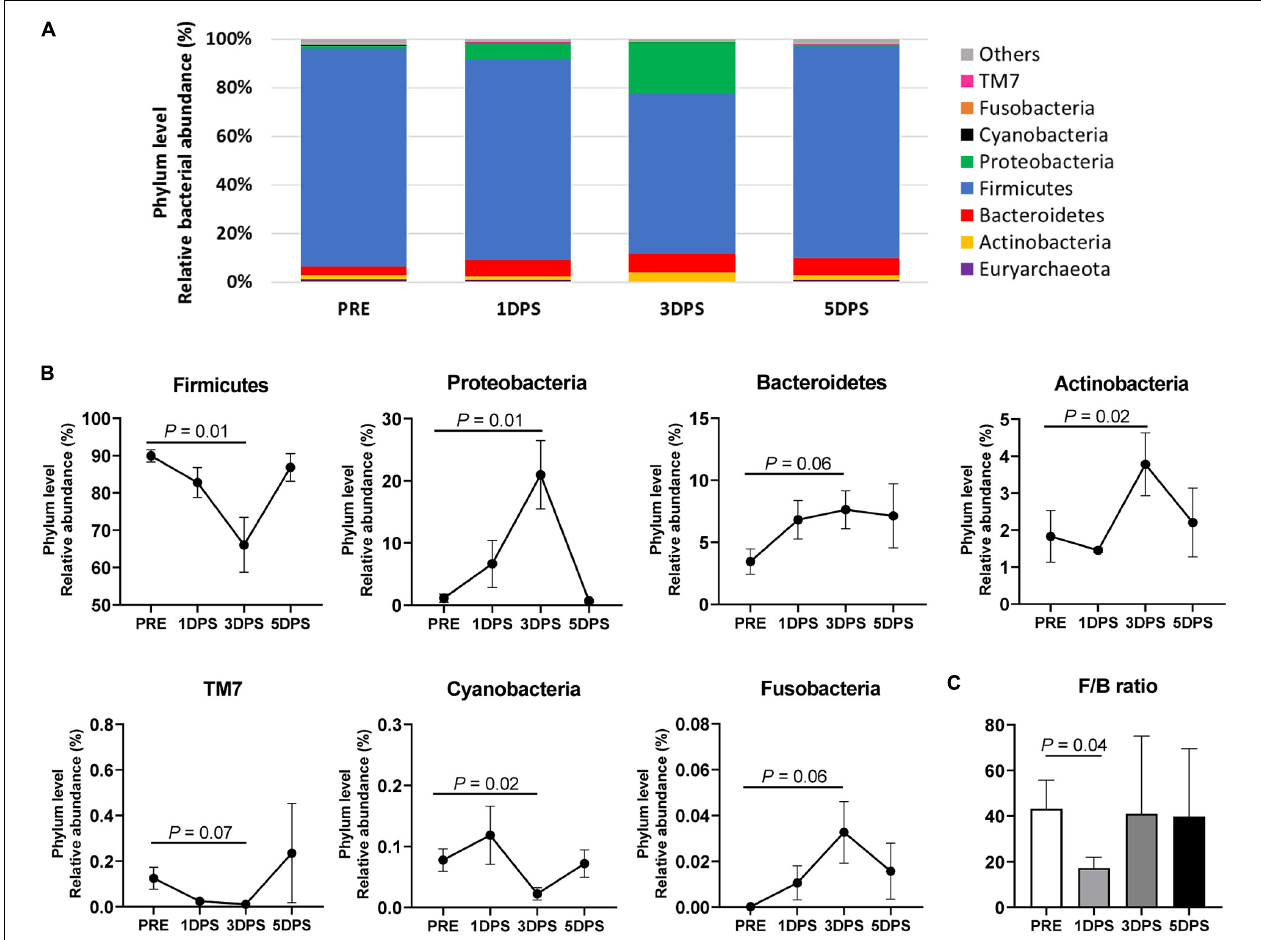
FIGURE 5 | Stroke resulted in phylum level perturbations in gut microbiota between pre- and poststroke in MCAO pig model. (A) Mean relative abundances of bacterial phylum prestroke (PRE, n = 7), 1 day poststroke (1 DPS, n = 7), 3 days poststroke (3 DPS, n = 6), and 5 days poststroke (5 DPS, n = 4) are shown. (B) Bacterial phyla showed changes in the abundance ( P < 0.10) during acute stage of stroke. (C) The ratio of Firmicutes to Bacteroidetes (F/B) at 1 day poststroke (1 DPS) was lower than that at prestroke (PRE), 3 days poststroke (3 DPS), and 5 days poststroke (5 DPS). P -value: paired t -test comparing the mean prestroke values vs. each time point